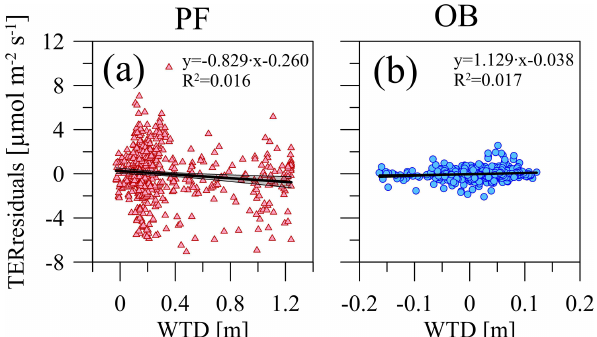
Figure 5. Relationship between the residuals of the Q 10 model (Fig. 4a and Table 5) calculated using soil temperature and WTD at the (a) paludified forest (PF) and (b) ombrotrophic bog (OB), with the linear fit and its 95% confidence interval.